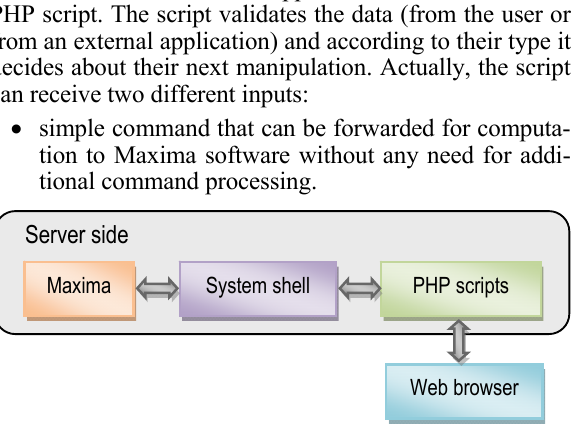
Figure 1. Schematic block scheme of Maxima online implementation